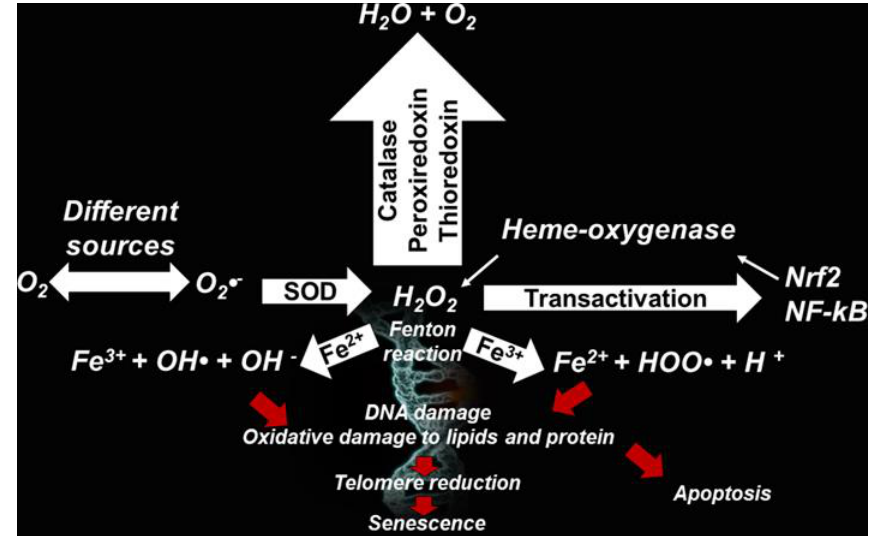
Figure 2. Pathways of reactive oxygen species (ROS) production.